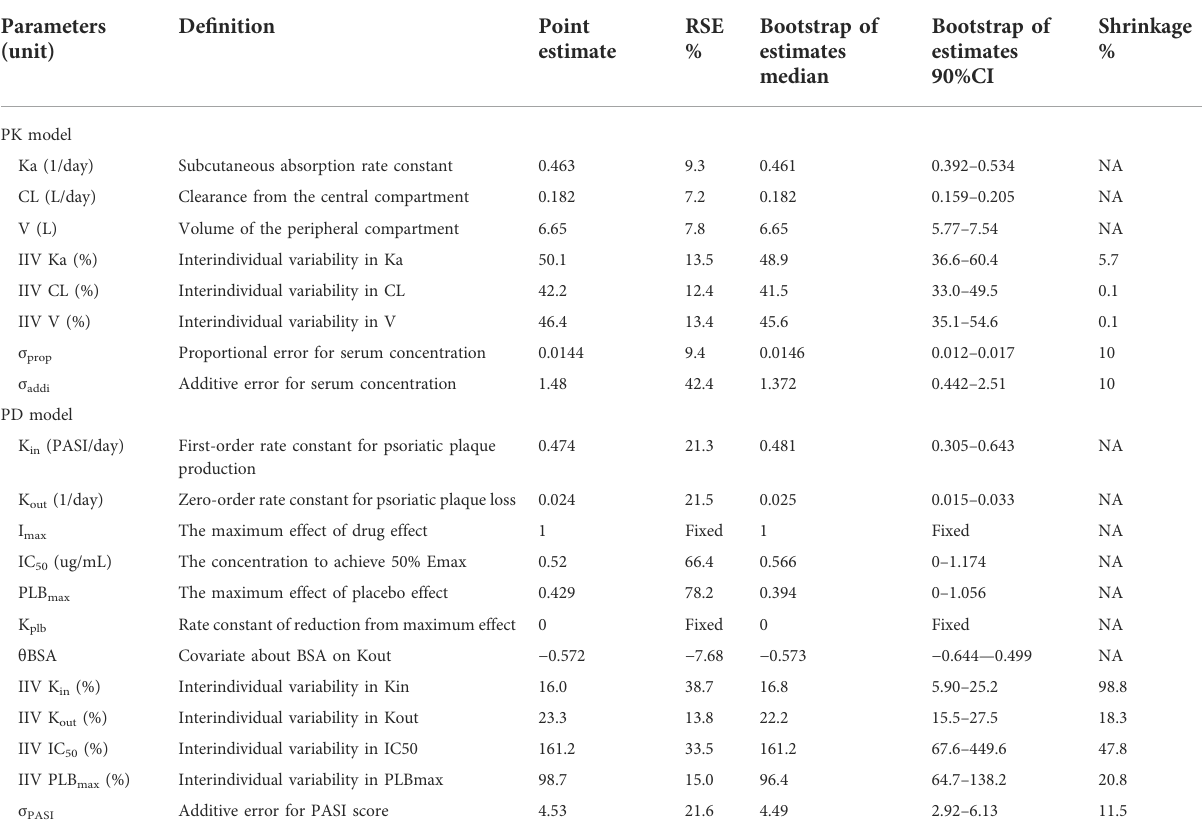
TABLE 2 The estimated value of the PK/PD parameters in the